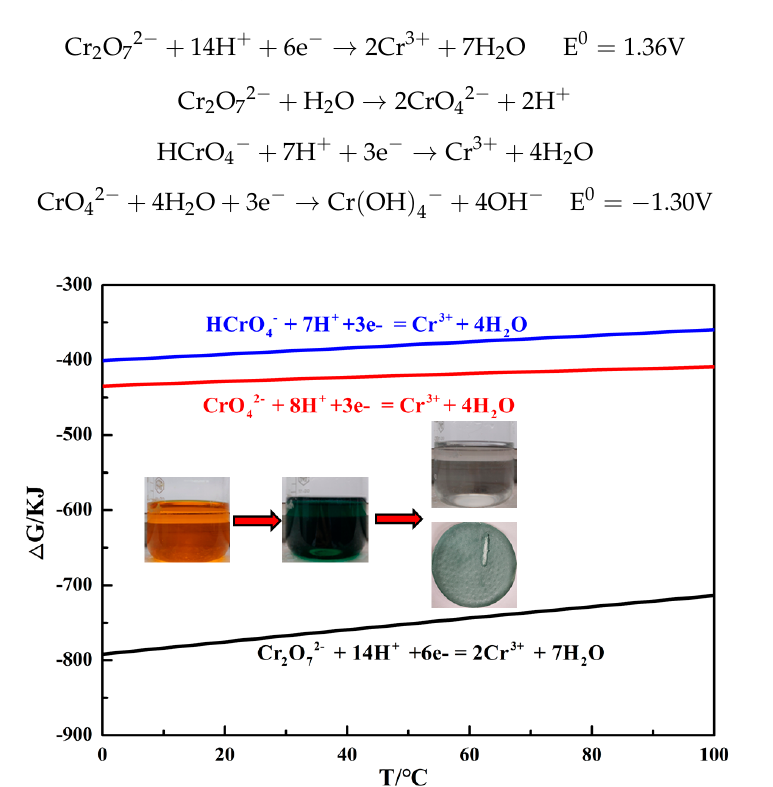
Figure 1. Relationship between ∆ G and the temperature of the reduction of chromium